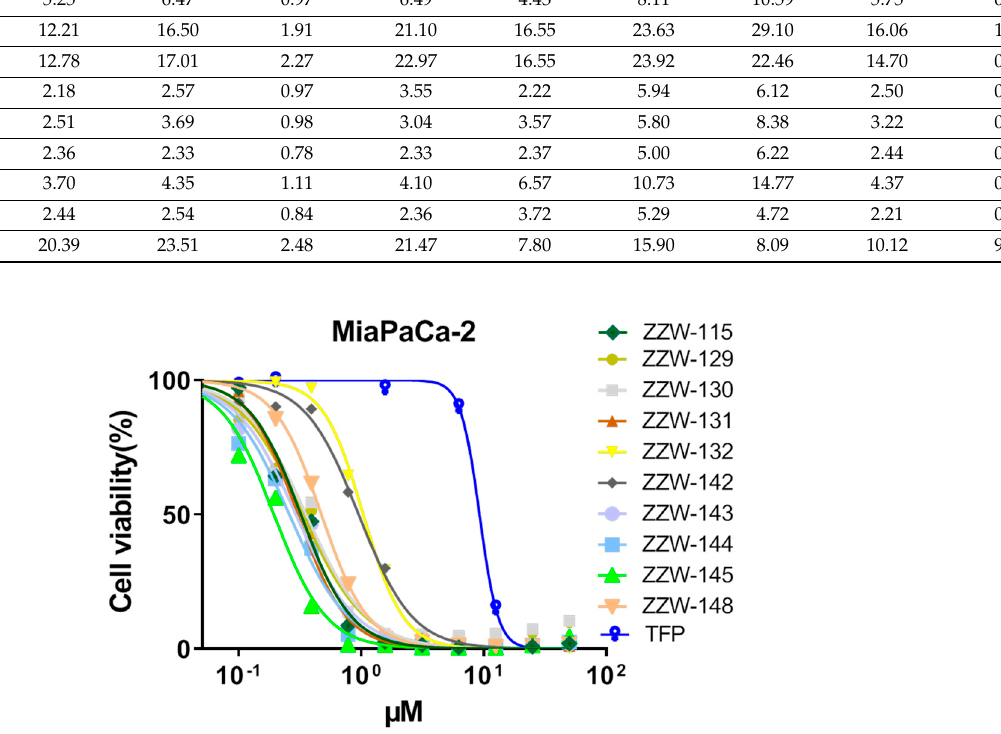
Figure 6. ZZW-115-derived compounds have antitumoral effect: Viability of MiaPaCa-2 cells upon a treatment for 72 h with the ZZW-115-derived compounds.